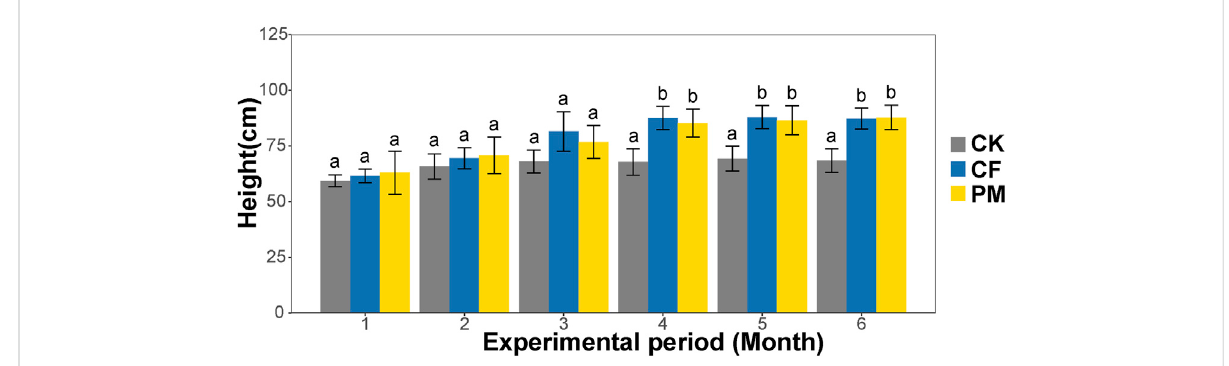
FIGURE 3 Plant heights of H. chrysanthus seedlings grown in soil with or without sludge addition (CK: the seedlings were grown in soil; CF: the seedlings were grown in soil with chemical fertilizers; PM: the seedlings were grown in soil amended by an equal mass of P. hybridum phyto-treated sludge. Different letters indicate that the difference was signi fi cant in the height between the treatments according to Duncan ’ s multiple range test ( n = 4, p =